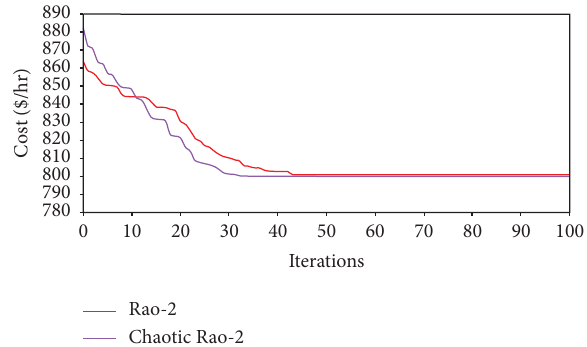
Figure 3: Convergence graphs obtained for case 1 using Rao-2 and the chaotic Rao-2 algorithms.